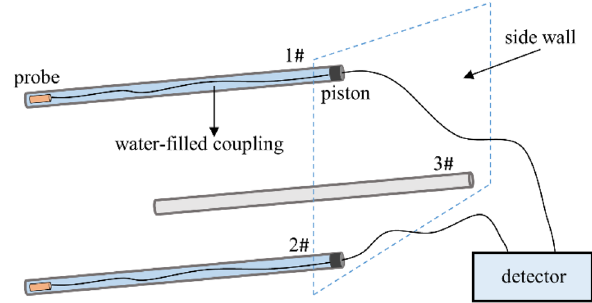
Figure 4. Two-hole sonic wave method test plan.